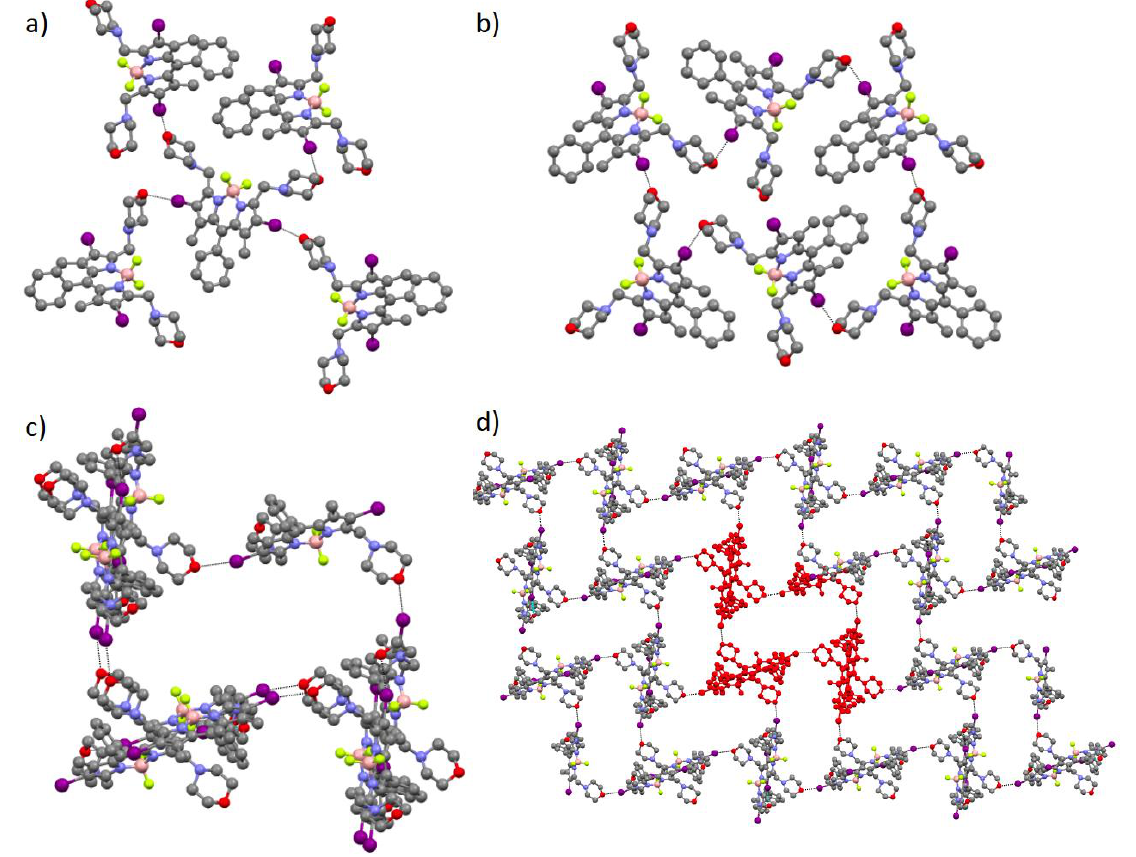
Figure 2. Views of the crystal structure of 3 illustrating the overall halogen bonded framework and illustrating ( a ) each molecule connected to four nearest neighbours, ( b ) the formation of a six-membered ring and ( c ) an adamantane-like unit that is a component of ( d ) the overall pseudo-diamondoid network. In ( d ) the adamantane-like unit, shown in ( c ), is highlighted in red. C = grey, N = blue, B = pink, F = green, I = purple, O = red, H = white. Black dashed lines represent C–I ··· O halogen bonds.